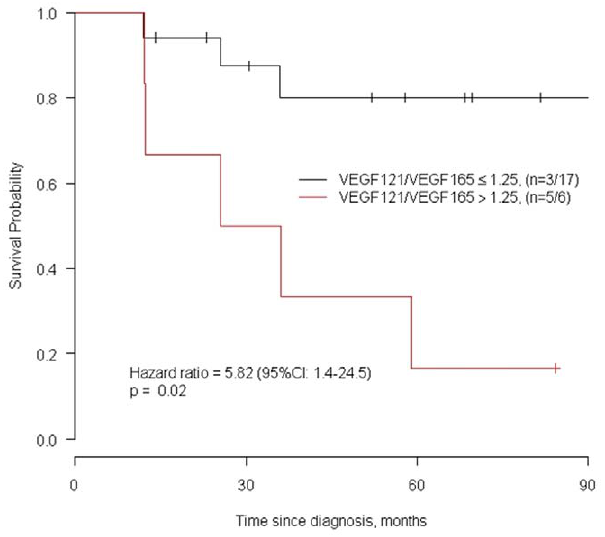
Figure 3. Kaplan-Meier survival curve according to the ratio VEGF 121 /VEGF 165.